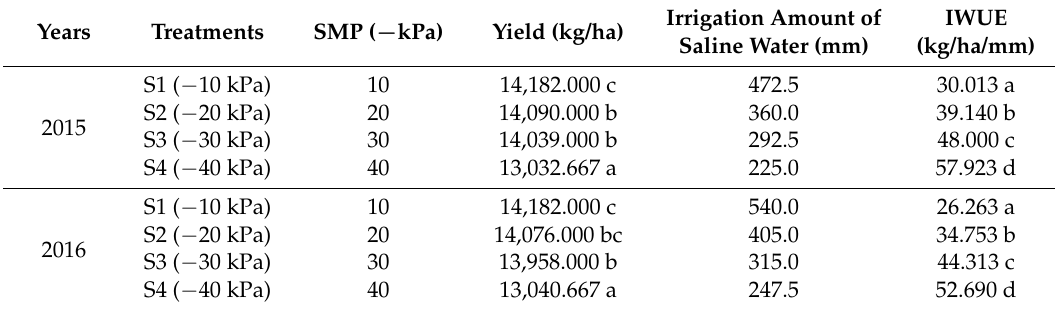
Table 8. Maize yield and irrigation water use efficiency (IWUE) for treatments in 2015 and 2016.